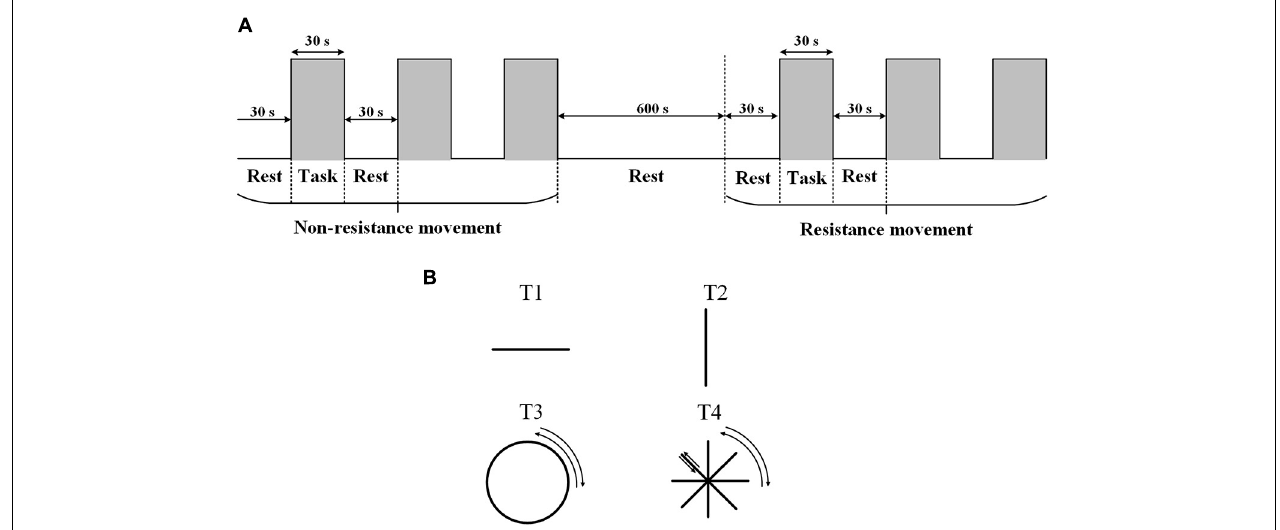
FIGURE 1 | The task paradigm. (A) The experiment consists of two parts: non-resistance movement and resistance movement. Each task contains three periodic motions: rest for 30 s and exercise for 30 s. The interval between the two exercises is 600 s. (B) Four trajectories. TABLE 1 | Anatomic labeling of functional near-infrared spectroscopy (fNIRS) channel position, Brodmann areas (BAs). Near-Infrared Spectroscopy (NIRS)